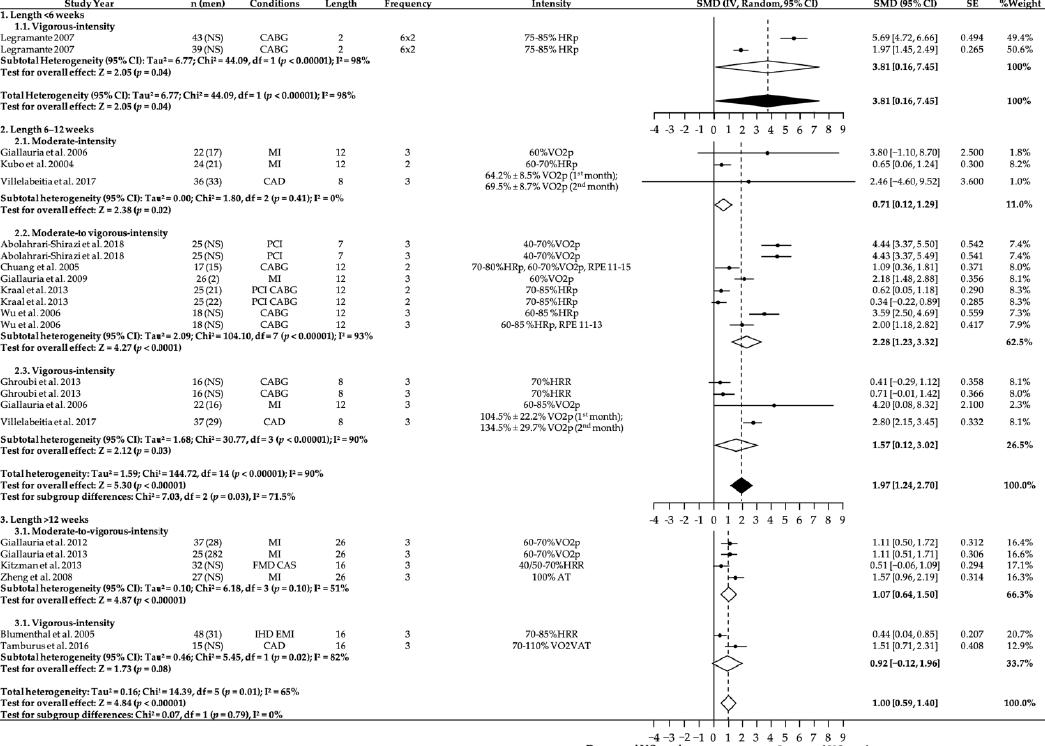
Figure 4. Effect of length in moderate-, moderate-to-vigorous- and vigorous-intensity exercise during exercise programs on change in relative VO 2 peak (mL-kg −1 -min −1 ). NS, not stated/missing. HRR, heart rate reserve. HRp, heat rate peak. RPE, rate of perceived exertion. AT, anaerobic threshold. VAT, ventilatory anaerobic threshold. 95% CI, 95% confidence interval. SMD, standardized mean differences. IV, Random: a random-effects meta-analysis is applied, with weights based on inverse variances. SE, standard error. Tau 2 and I 2 , heterogeneity statistics. df, degrees of freedom. Chi 2 , the chi-squared test value. Z, Z-value for test of the overall effect. P, p-value. Conditions: MI, myocardial infarction. CABG, coronary artery bypass graft. PCI, percutaneous coronary intervention. CAD, coronary artery disease. IHD, ischemic heart disease. EMI, exercise-induced myocardial ischemia. FMD, endothelial-dependent flow-mediated arterial dilation. CAS, carotid artery stiffness.